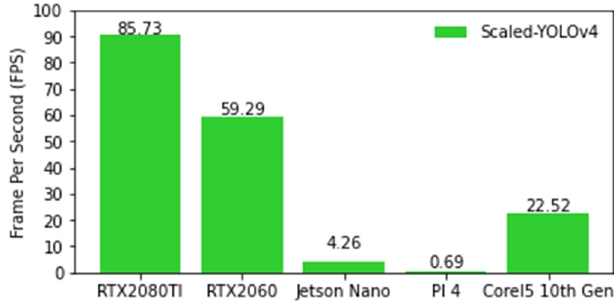
Figure 14. Comparison of FPS on different computing devices.